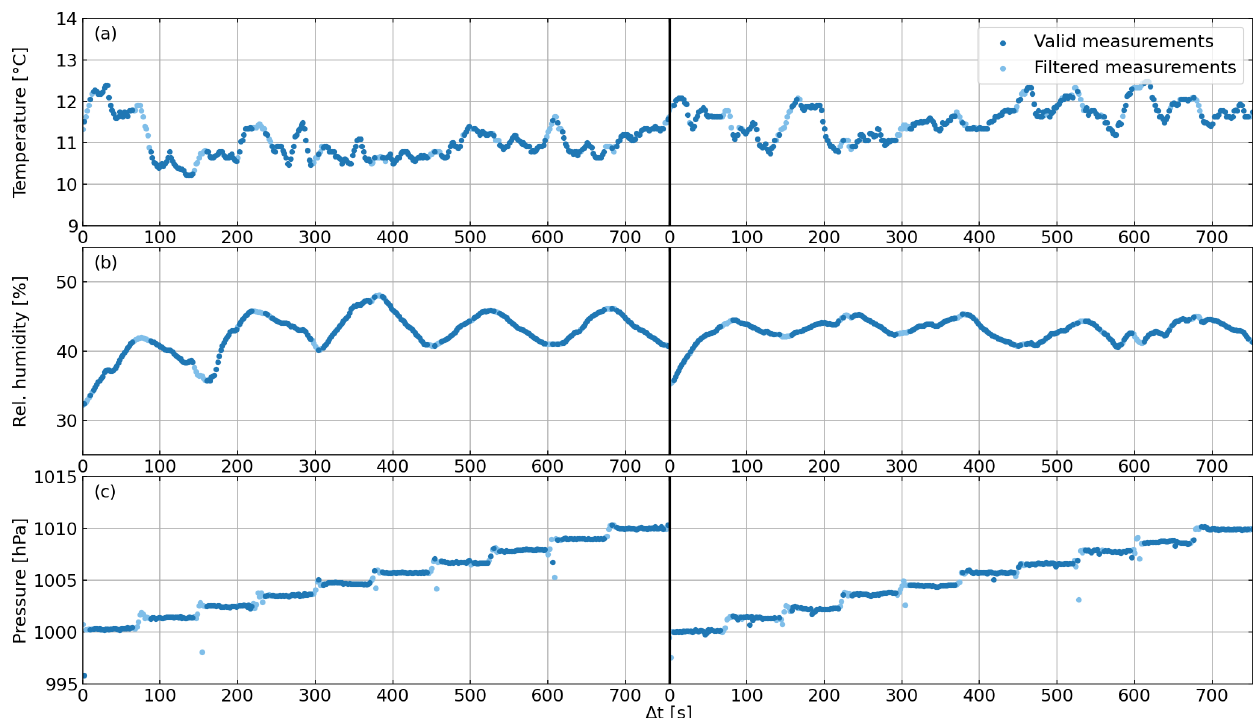
Figure A3. Temperature (a) , relative humidity (b) , and pressure measured (c) during two flights downwind of the ExxonMobil natural gas processing facility in Großenkneten 40km west of Bremen, Germany, 10 April 2020. Left: flight 1. Right: flight